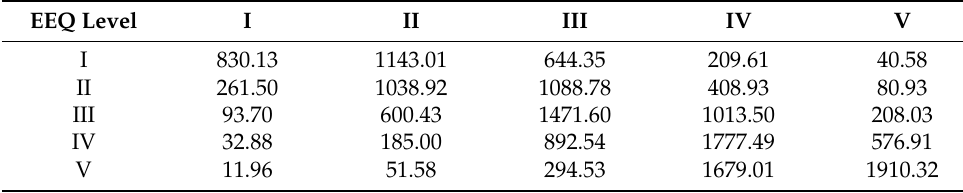
Table 1. The transition matrix of EEQ levels during 2010–2015.